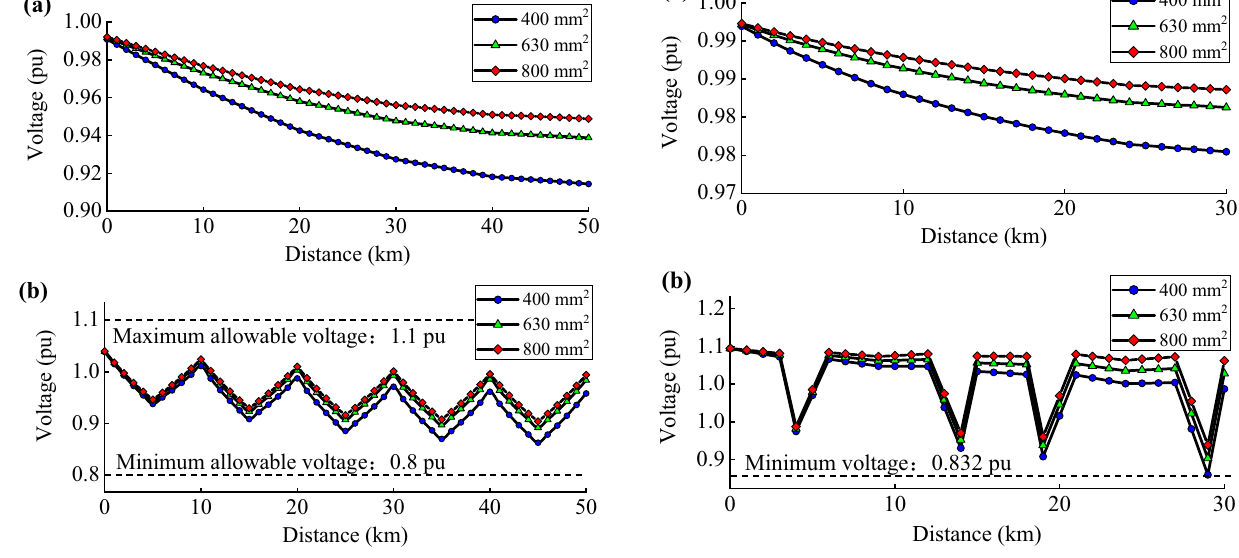
Fig. 16 Voltage distribution of TTPSS at closely running: a CTN; b TTN